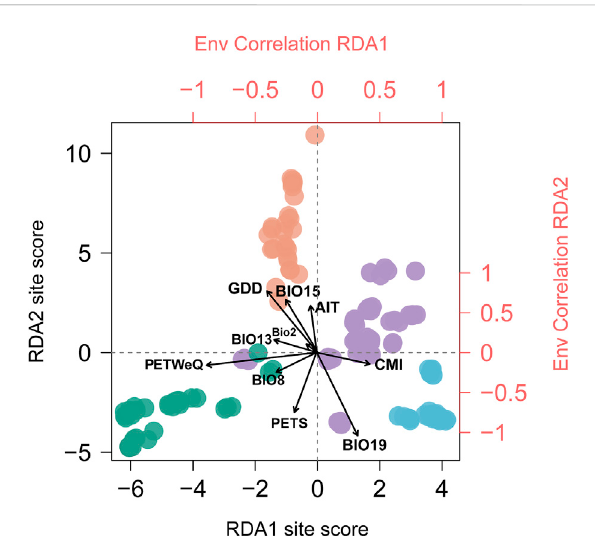
FIGURE 2 Biplot of Redundancy analysis conditioned on geography. Individualsare colored in corresponding with geneticclustersinferred by STRUCTURE analysis (see Figure 1). Top and right axes in red displayed the correlation of each climate variable (see Supplementary Table S2 for variable abbreviations) with RDA1 and RDA2 axes, respectively. Black vectors represent climate